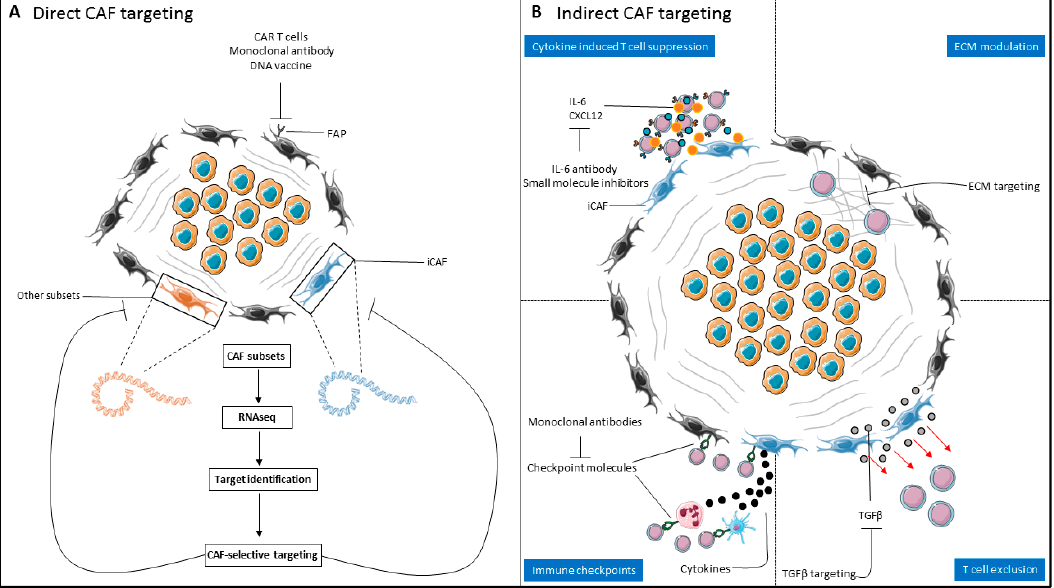
Figure 2. Therapeutic targeting of CAFs to enhance T-cell based immunotherapies. ( A ) Direct CAF targeting relies on the identification of CAF-selective targets to reduce ‘on-target o ff -CAF’ toxicity. RNA-sequencing based approaches enable identification of markers to target specific immunomodulatory CAF subsets. ( B ) Indirect CAF targeting relies on targeting of CAF-derived factors involved in T-cell exclusion and suppression. This can be done either through inhibiting CAF-derived cytokines involved in suppressing T-cell function (top-left), modulation of the ECM (top-right) or blocking of inhibitory chemotactic signals (e.g., TGF- β signaling) to improve accessibility of T-cells to the tumor (bottom-right) and / or inhibition of checkpoint molecules on CAFs or associated immune cells to potentiate tumoricidal T-cell e ff ector functions (bottom-left). CAR, chimeric antigen receptor; FAP, fibroblast activation protein; CAF, cancer-associated fibroblast; iCAF, inflammatory CAF; IL-6, interleukin-6; ECM, extracellular matrix; TGF- β , transforming growth factor β